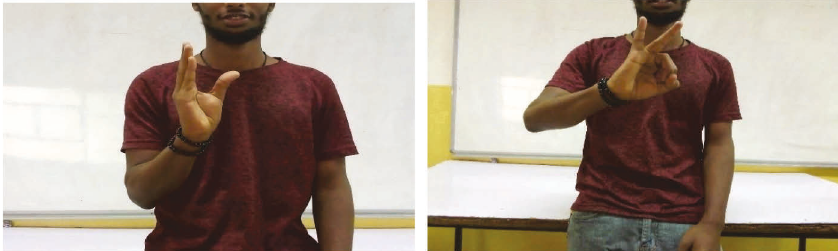
Figure 2: Sign representation of two different characters ( and , respectively).